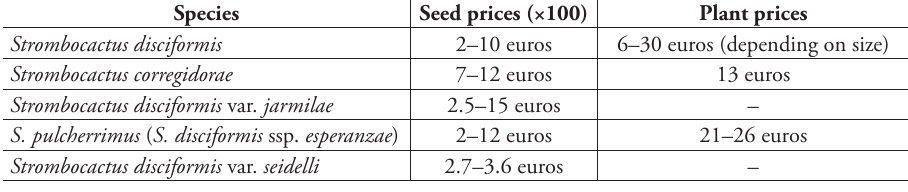
Table 1. Online price of the different species and varieties of the genus Strombocactus (Cactaceae) for one unit in the case of plants and for 100 units in the case of seeds, during the period of March-April 2014, and reviewed at the end of 2015, using the https://www.google.com.